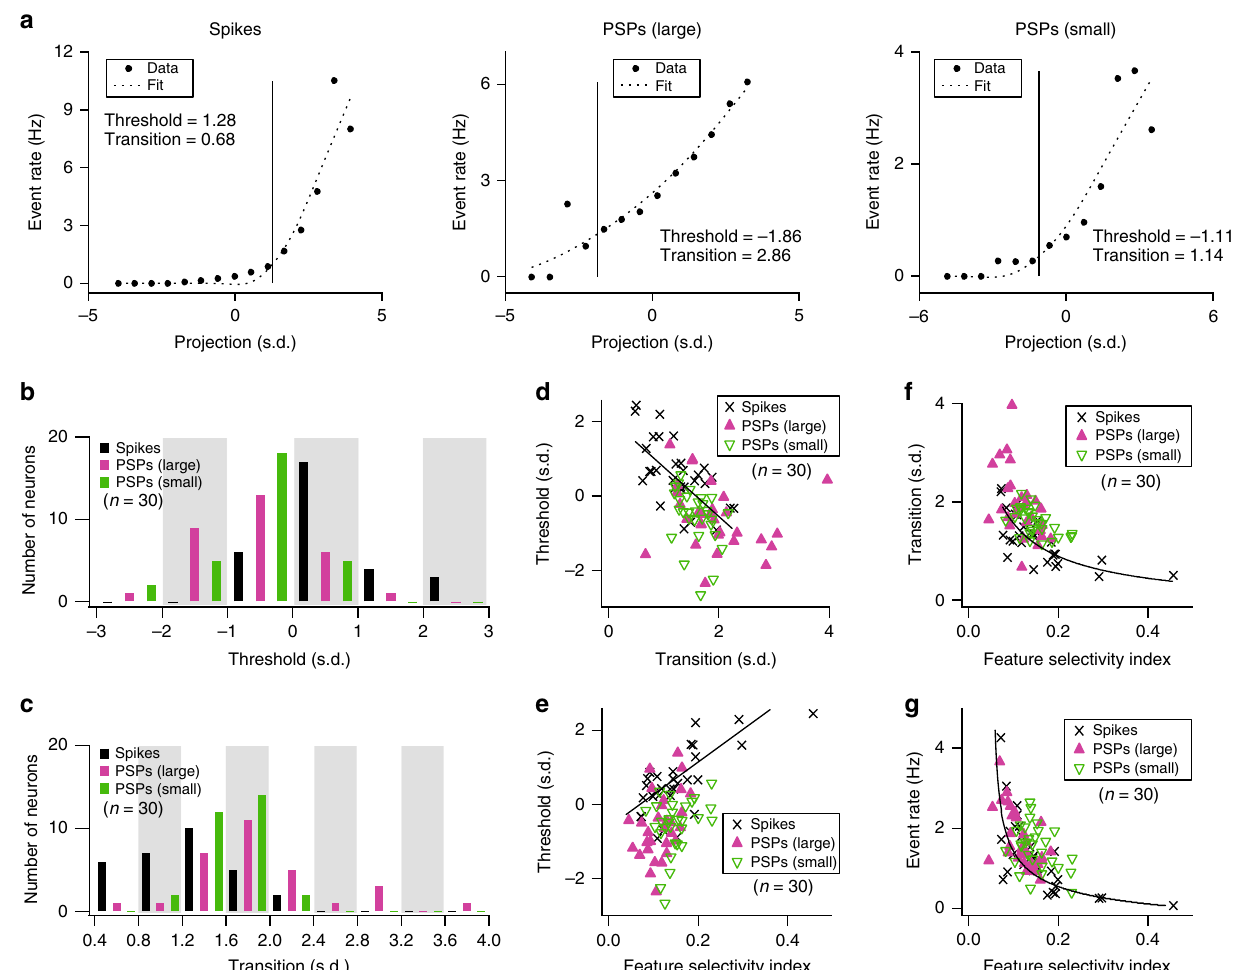
Fig. 6 Nonlinearities of STRFs. a A representative example illustrates different nonlinearities for spikes and PSPs. b Histograms of thresholds ( n = 30/40 neurons with signi fi cant STRF sub fi elds for spiking, large PSP, and small PSP events; Pearson ’ s r = 0.024 and p = 0.9 between small PSPs and spikes; Pearson ’ s r = 0.075 and p = 0.7 between large PSPs and spikes). The width of a gray bar corresponds to a bin size. Three histograms for spikes, large PSPs, and small PSPs are plotted together in each bin. c As in b , but for histograms of transitions ( n = 30/40 neurons with signi fi cant STRF sub fi elds for spiking, large PSP, and small PSP events; Pearson ’ s r = − 0.007 and p = 0.97 between small PSPs and spikes; Pearson ’ s r = − 0.078 and p = 0.68 between large PSPs and spikes). d Relationship between thresholds and transitions ( n = 30/40 neurons with signi fi cant STRF sub fi elds for spiking, large PSP, and small PSP events). e Relationship between thresholds and feature selectivity indexes ( n = 30/40 neurons with signi fi cant STRF sub fi elds for spiking, large PSP, and small PSP events; linear fi t, Pearson ’ s r = 0.68, p = 2 × 10 − 5 for spikes; Pearson ’ s r = 0.39, p = 0.0294 for large PSPs; Pearson ’ s r = 0.30, p = 0.1045 for small PSPs). f Relationship between transitions and feature selectivity indexes ( n = 30/40 neurons with signi fi cant STRF sub fi elds for spiking, large PSP, and small PSP events; power fi t, Pearson ’ s r = − 0.67, p = 4 × 10 − 5 for spikes; Pearson ’ s r = − 0.50, p = 0.0045 for large PSPs; Pearson ’ s r = − 0.54, p = 0.0019 for small PSPs). g Relationship between event rates and feature selectivity indexes ( n = 30/40 neurons with signi fi cant STRF sub fi elds for